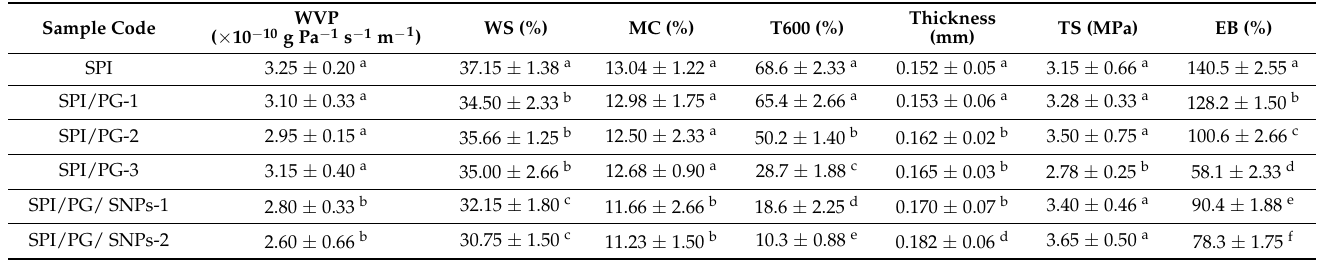
Table 2. Physico-mechanical properties of SPI/PG/SNPs active